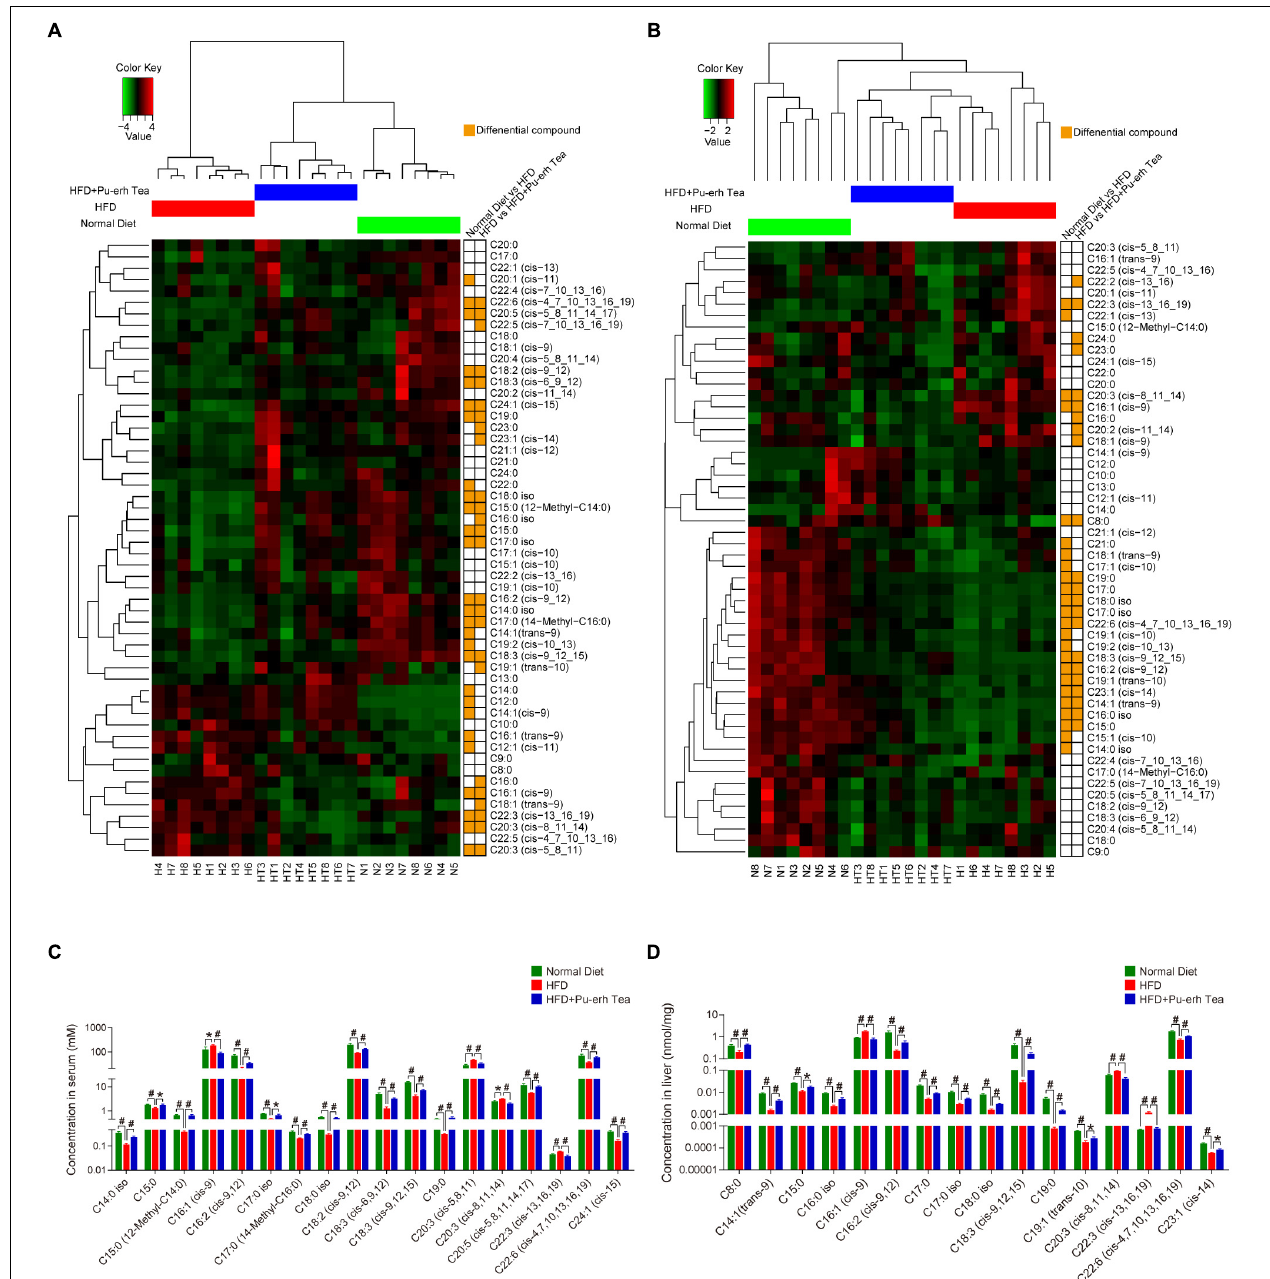
FIGURE 3 | FFA profile and differential FFAs induced by HFD and Pu-erh tea treatment. (A) Heatmap based on Z -scores of serum FFAs in mice fed with control diet, HFD, and HFD with 450 mg/Kg/day Pu-erh tea for 22 weeks. (B) Heatmap based on Z -scores of hepatic FFA profile of mice fed with control diet, HFD, and HFD with 450 mg/Kg/day Pu-erh tea for 22 weeks. (C) Concentrations of differential FFAs in serum of mice fed with control diet, HFD, and HFD with 450 mg/Kg/day Pu-erh tea for 22 weeks. (D) Concentrations of differential FFA in liver of mice fed with control diet, HFD, and HFD with 450 mg/Kg/day Pu-erh tea for 22 weeks. Data were expressed as mean ± SEM and differences were assessed by Mann–Whitney U test, ∗ p < 0.05, # p <